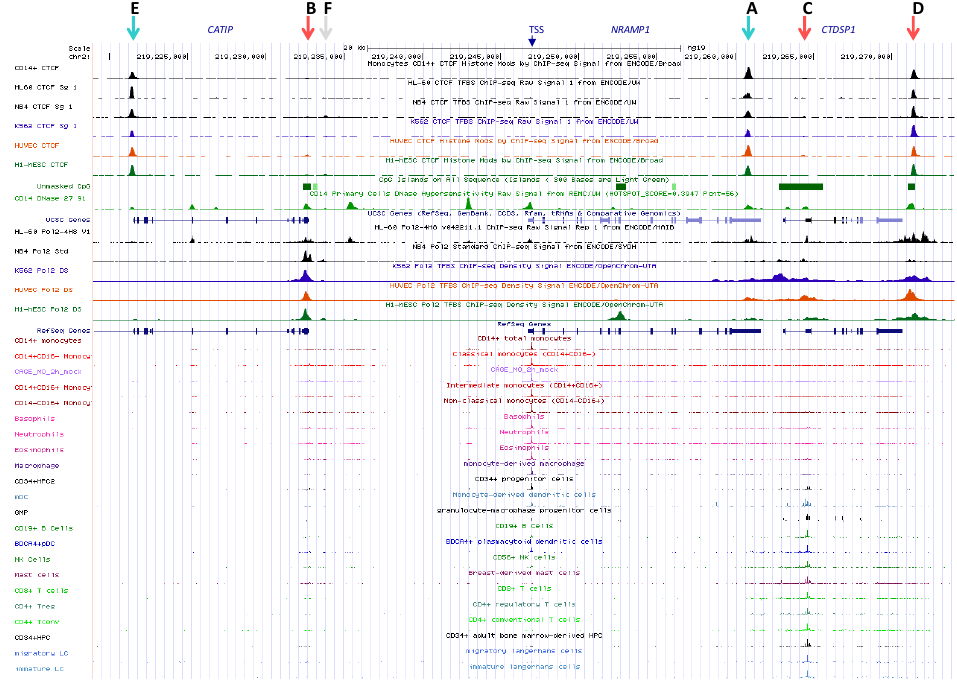
Figure 1. CAGE at NRAMP1 locus in blood cell types. From top to bottom: CTCF sites are shown by arrows (red, forward orientation; blue, reverse orientation; grey, undetermined), including NRAMP1 locus boundaries (sites A and E), and NRAMP1 TSS as well as surrounding genes are indicated; chromosome 2 scale; CTCF ChIP-seq data for CD14 + monocytes (MNs), acute promyelocytic leukemia HL-60 and NB4, erythroleukemia K562, human umbilical vein epithelial cells (HUVEC) and embryonic stem cells (ESC; data from ENCODE consortium [9,10]); CpG islands; DNAse1 footprints: hypersensitive sites (DHS) in CD14 + MNs (ENCODE) [9,10]; UCSC browser genes; RNA Pol II ChIP-seq data for HL-60, NB4, K562, HUVEC and ESC (ENCODE); RefSeq genes; CAGE data [16,17] for 22 blood cell